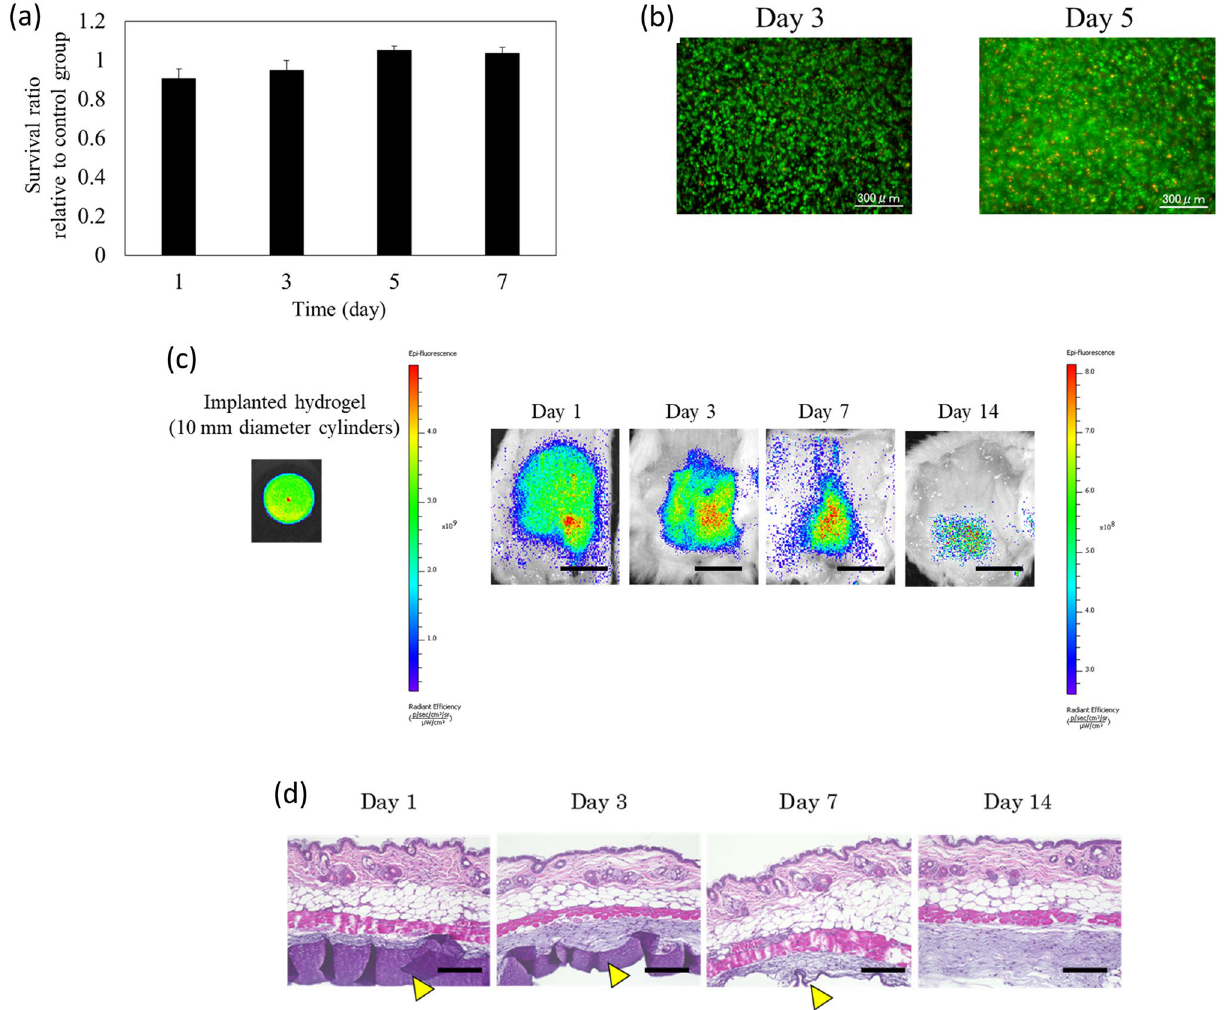
Figure 2. Evaluation of in vitro and in vivo biocompatibility of photocrosslinked gelatin hydrogels. ( a ) Cytotoxicity towards L929 fibroblasts after incubation with hydrogel extracts for 1, 3, 5, and 7 days ( n = 8 per group). Experimental data were represented by dividing each value by that of the control group (incubated with normal culture medium) for each day (error bars, mean ± SD). ( b ) Live/dead staining of L929 fibroblasts encapsulated in the hydrogels after 3 and 5 days of incubation. L929 fibroblasts were stained with calcein-AM to detect living cells (green) and ethidium homodimer-1 to detect dead cells (red). Scale bar: 300 μm. ( c ) Macroscopic appearance of excised photocrosslinked gelatin hydrogel #1 implants after 1, 3, 7, and 14 days of implantation ( n = 5 per group). At designated time intervals, the fluorescence of the remaining hydrogel in mouse subcutaneous tissue was imaged using the IVIS Lumina XR, and the fluorescence intensity was analyzed with Living Image Software (PerkinElmer Inc., MA). Scale bar: 10 mm. ( d ) After imaging, the subcutaneous tissues were processed for histological analyses. Pathological staining with hematoxylin and eosin showed several inflammatory cells near the hydrogel–tissue interface on day 1, indicating a post-operative inflammatory response. However, this inflammatory response disappeared within 3 days. The yellow arrowhead indicates the remaining hydrogel. Scale bar: 200 photoinitiator in each organ. The implanted hydrogel was excised at 1, 3, 7, and 14 days. The hydrogel implant size increased after implantation due to initial osmotic swelling and then decreased with time as the hydrogel was